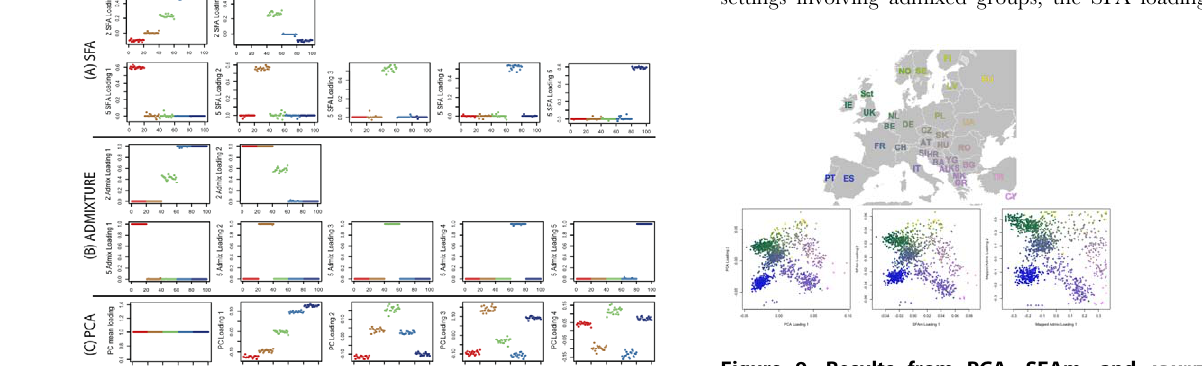
Figure 9. Results from PCA, SFAm, and ADMIXTURE for the POPRES European data. These results were rotated (but not rescaled) to make the correspondence to the map of Europe more immediately obvious. The results from SFAm are very similar to the results from PCA for these data, effectively recapitulating the geography of